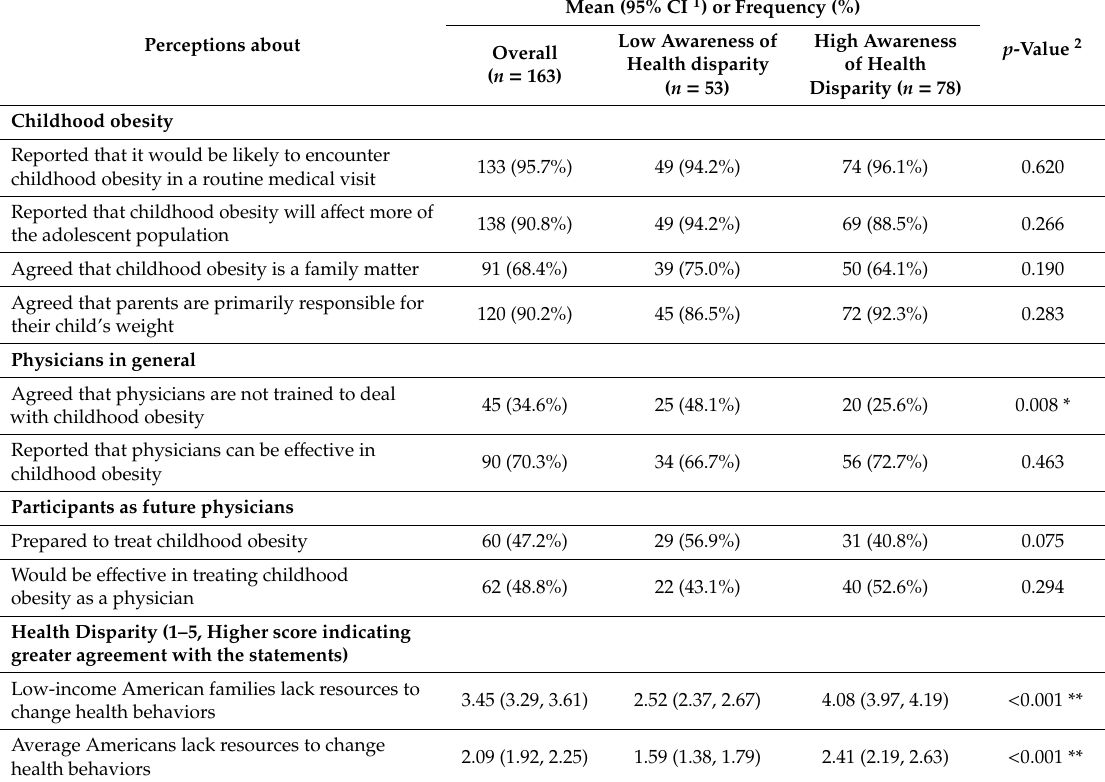
Table 2. Participants’ perceptions related to childhood obesity by their health disparity